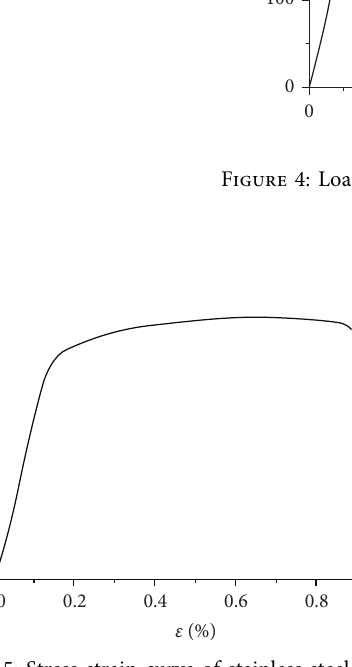
Figure 5: Stress-strain curve of stainless steel